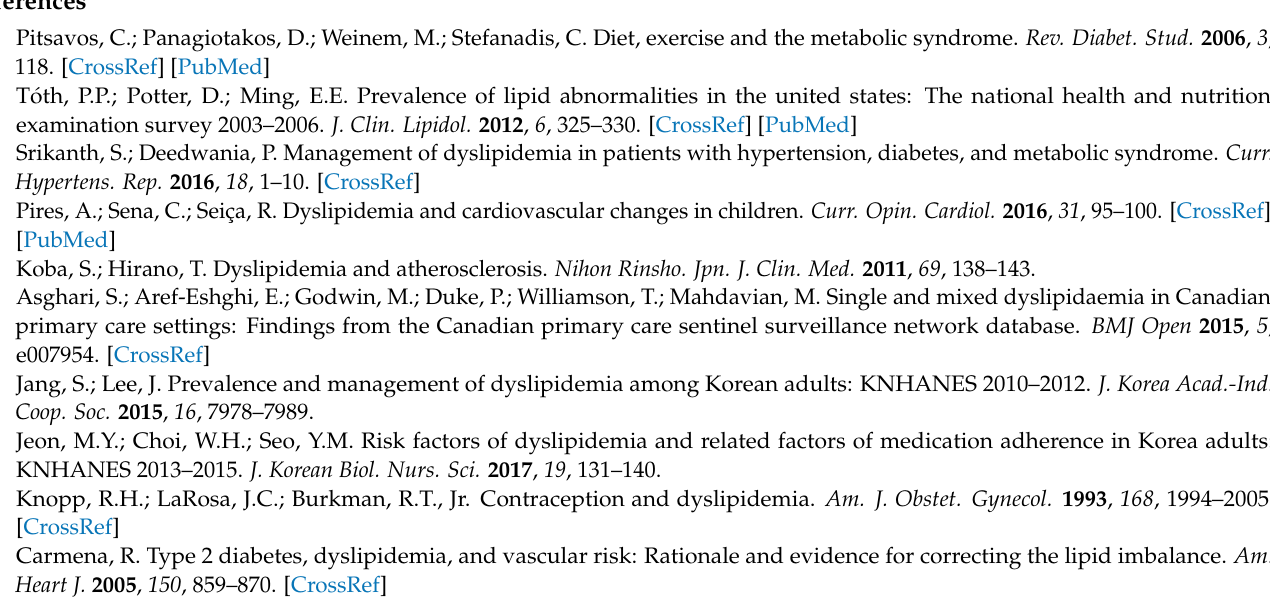
Table S2: High seafood dietary group-adjusted OR (95% CIs) of serum lipid profiles by heavy metal concentrations in participants ( n = 2591); Table S3: Heavy metals related occupation-adjusted OR (95% CIs) of serum lipid profiles by heavy metal concentrations in participants ( n =